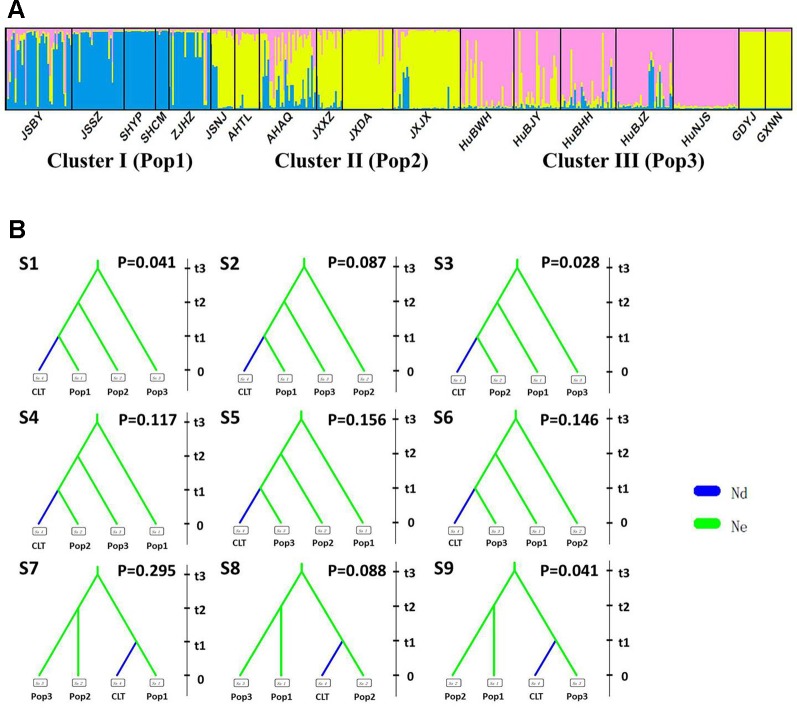
Genetic structure and settings of nine competing scenarios in the southern genetic group of wild Zizania latifolia. (A) The subtle genetic structure in the southern genetic group of Z. latifolia revealed by STRUCTURE. Each vertical bar represents an individual, and each color represents a cluster in the histograms of STRUCTURE. (B) 9 competing scenarios for ABC simulations inferring the origin of cultivars in the south group of wild Z. latifolia populations. CLT is the cultivated group, Pop1 is the Hongze-Tai lake group, Pop2 is the Poyang lake group, and Pop4 is the Dongting lake group.